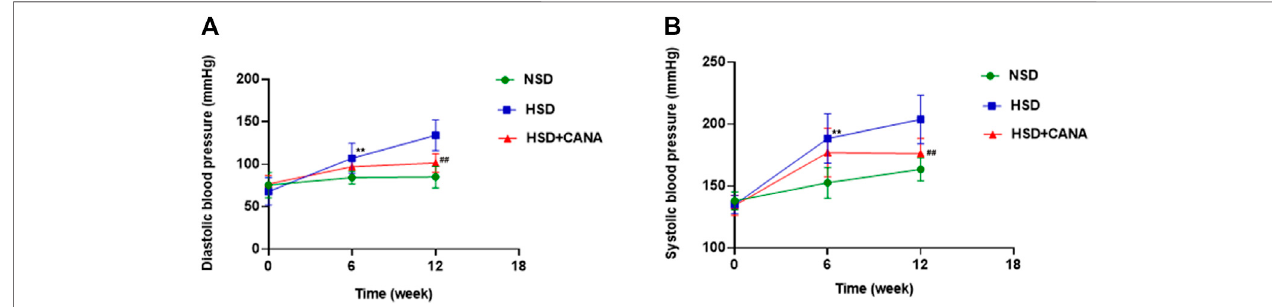
FIGURE 1 | Effects of CANA on blood pressure at 0, 6, and 12 weeks. (A) Effect of CANA on diastolic blood pressure of DSS rats; (B) Effect of CANA on systolic blood pressure of DSS rats. CANA, canagli fl ozin; NSD, normal-salt diet; HSD, high-salt diet. ** p < 0.01 vs. NSD. ## p < 0.01 vs. HSD.